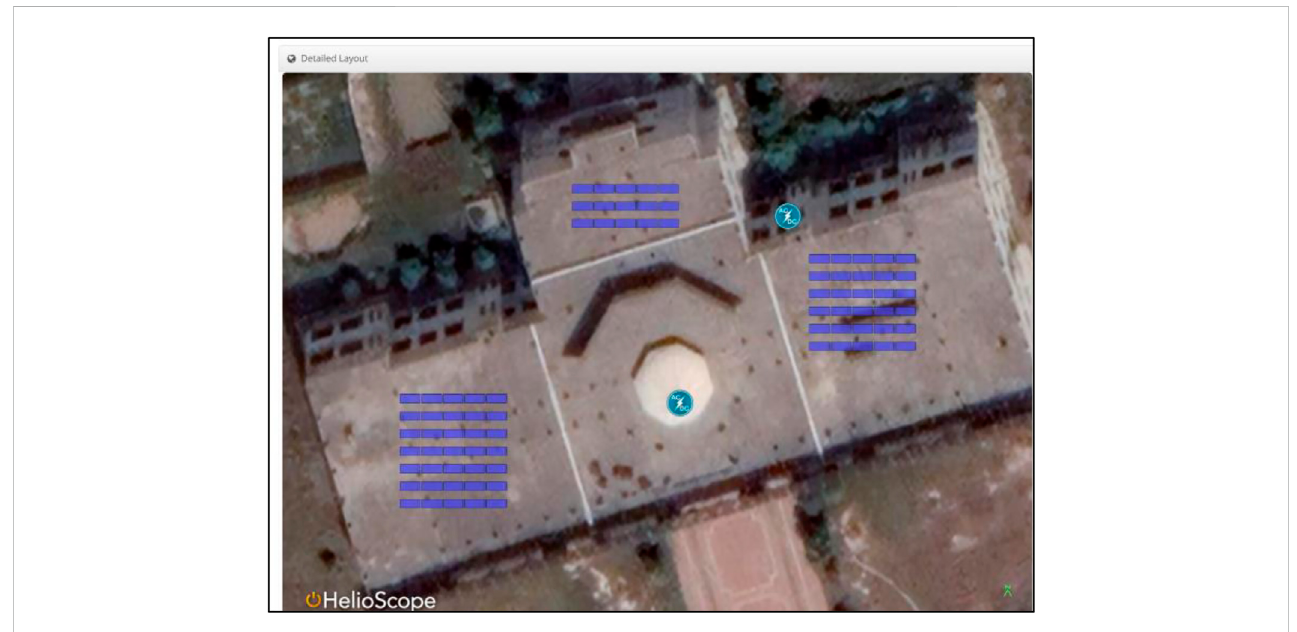
FIGURE 7 Detailed layout of solar system design.